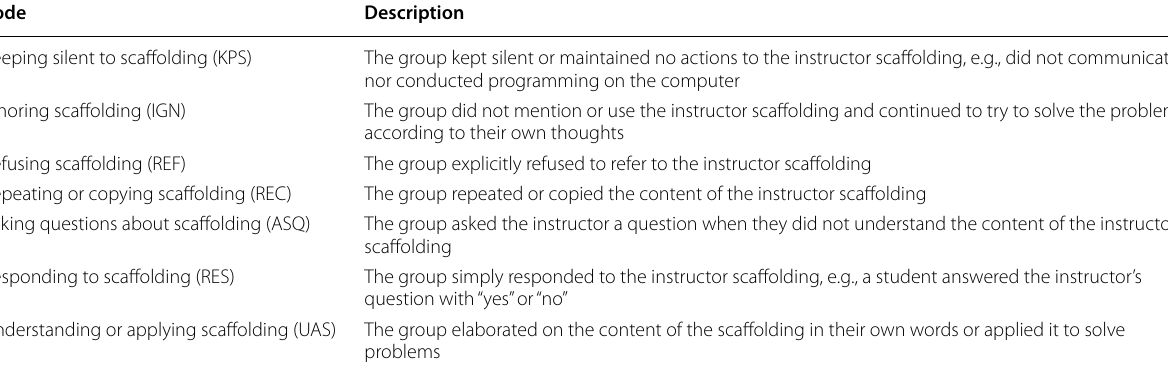
Table 3 The coding framework of groups’ immediate uptakes of instructor scaffoldings (c.f. Barron,